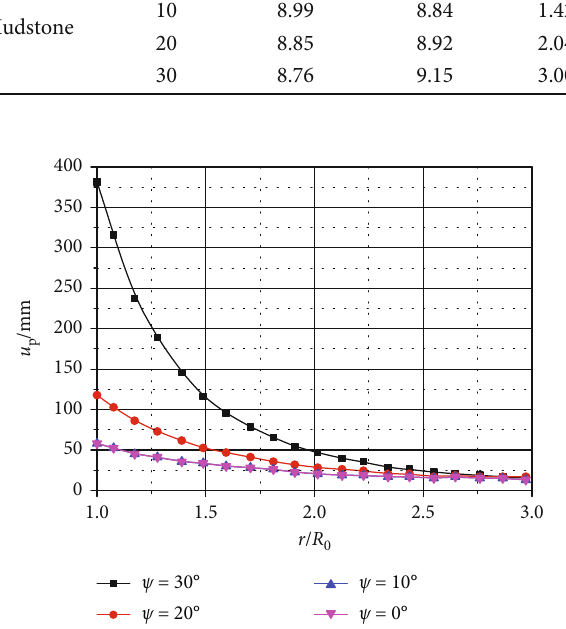
Figure 12: E ff ect of dilation angle on plastic zone of roadway surrounding rock displacement of the soft